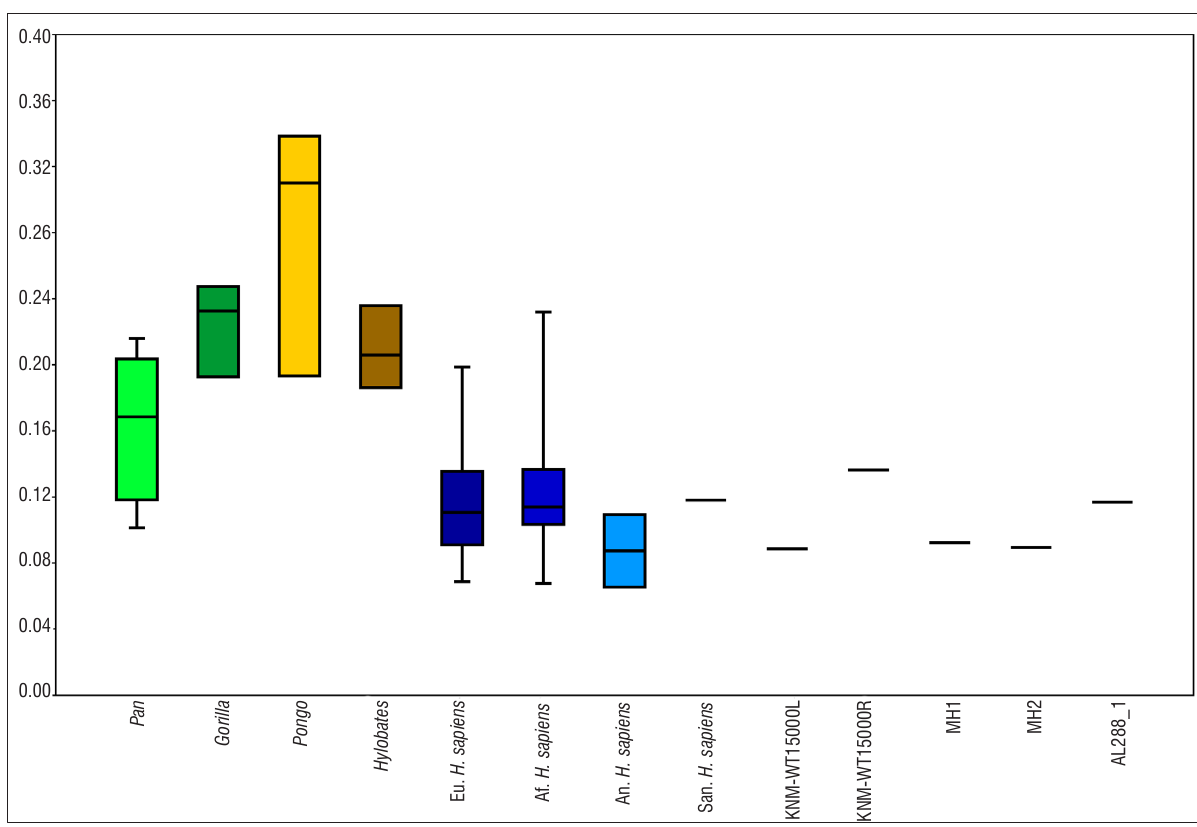
Figure 7: Box plot comparing the Procrustes distances between StW 670 (distance: 0.00) and the comparative sample. The closest groups to StW 670 are Australopithecus sediba (mean distance=0.09), small-bodied Andaman (An) Homo sapiens (mean distance=0.09), European (Eu) H. sapiens (mean distance=0.11), H. erectus (mean distance=0.11), small-bodied San H. sapiens (distance=0.12), A. afarensis (0.12) and sub-Saharan African (Af) H. sapiens (mean distance=0.13). The farthest groups are Pan (mean distance=0.16), Hylobates (mean distance=0.21), Gorilla (mean distance=0.22) and Pongo (mean